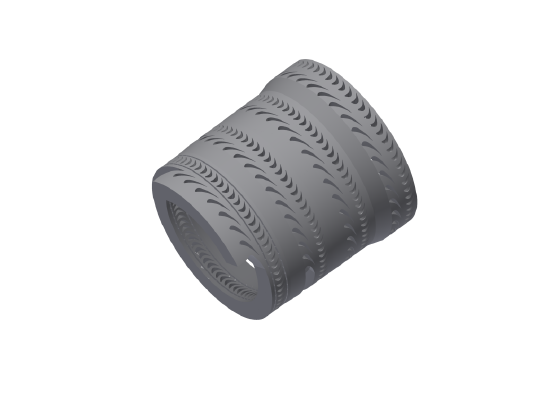
Figure 1: CAD geometry of the full four stages of the 100 kW ORC turbine.